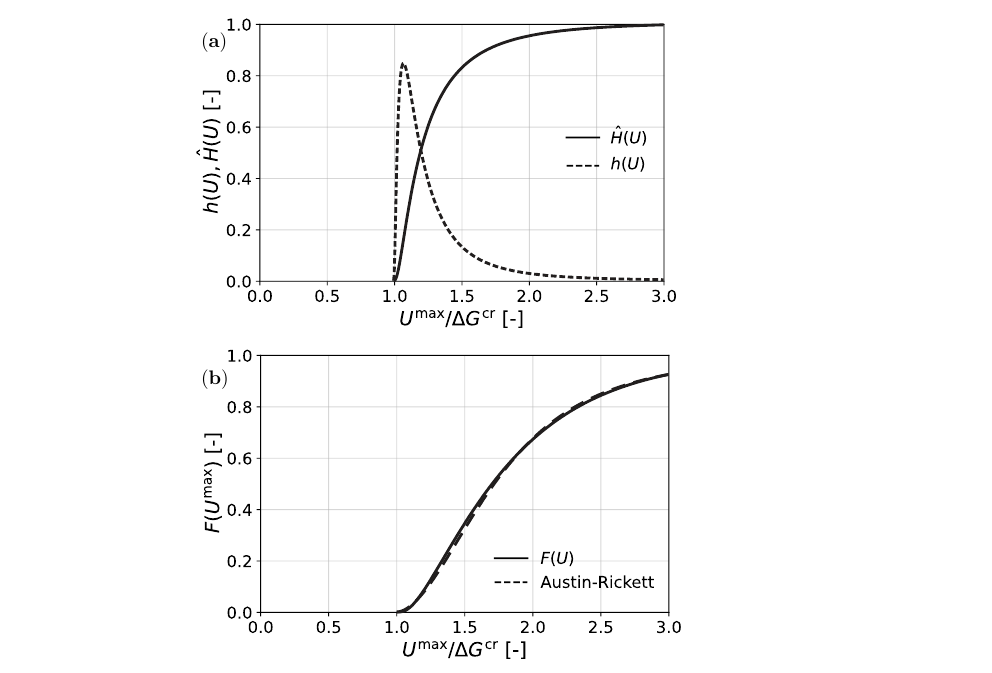
Figure 3. Transformation kinetics of TRIP steel: ( a ) probability density and cumulative distribution of required driving force and ( b ) function F ( U ) for martensite